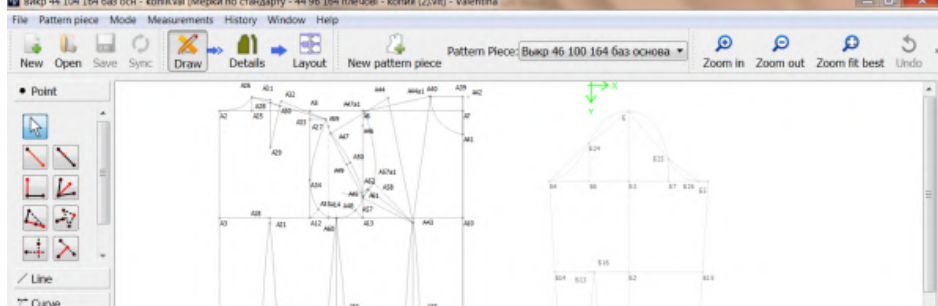
Figure 75: Presentation of paper [332]. Fig. 3. Dynamics of formation of the value component of ID competence of control and experimental group students.